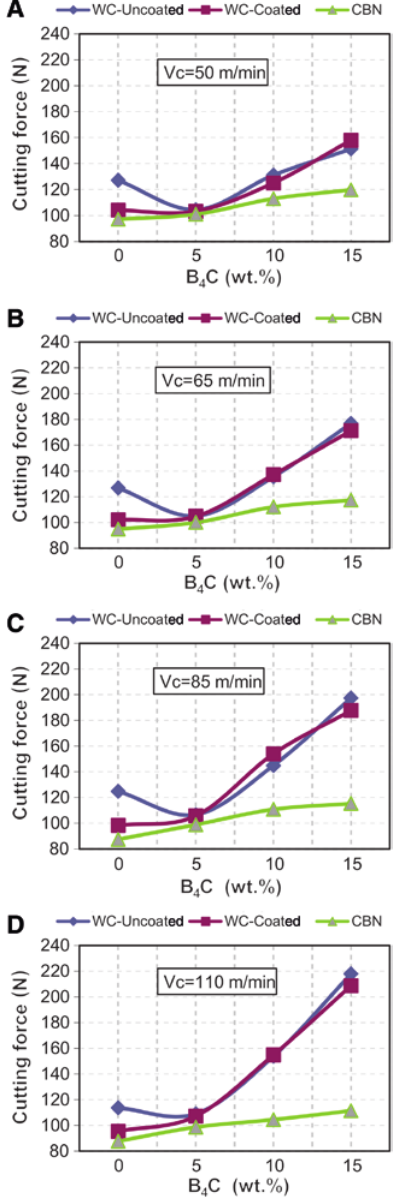
Figure 7: The variation of cutting forces depending on the particle amount increase: (A) 50 m/min, (B) 65 m/min, (C) 85 m/min and (D) 110 m/min cutting